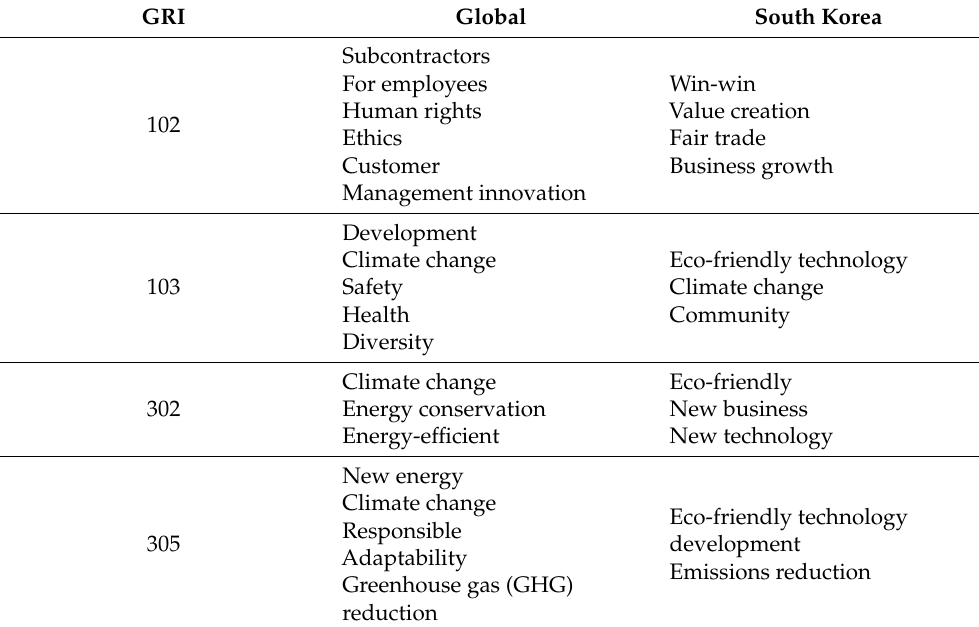
Table 14. Comparison of common keywords in four GRI codes corresponding to the top 5 between global and South Korean